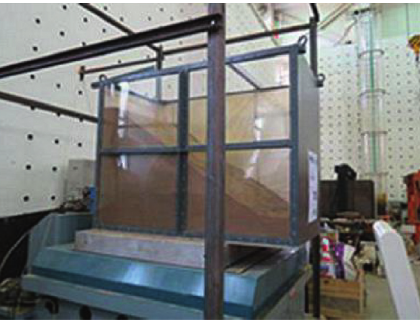
Figure 9: Test model of the